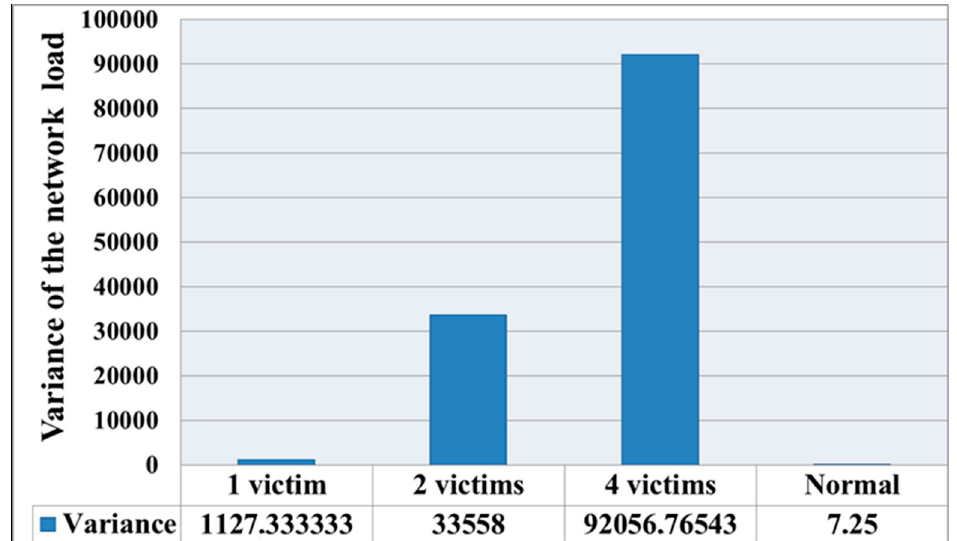
various numbers of victims.